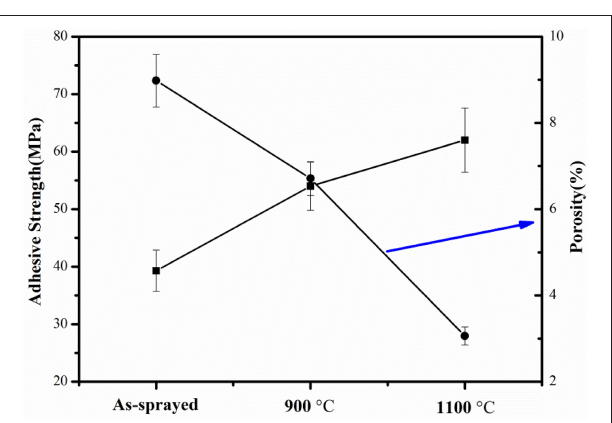
FIGURE 5 | Adhesive strength and porosity of coating at different heat treatment temperatures.